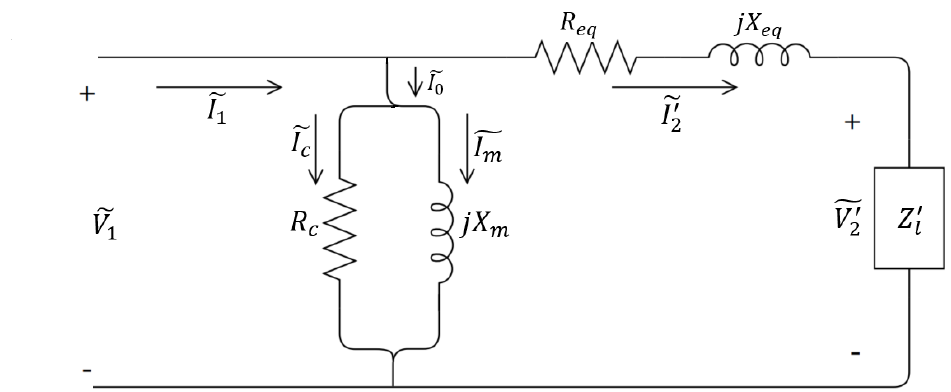
Figure 2. Single-phase aproximate transformer equivalent